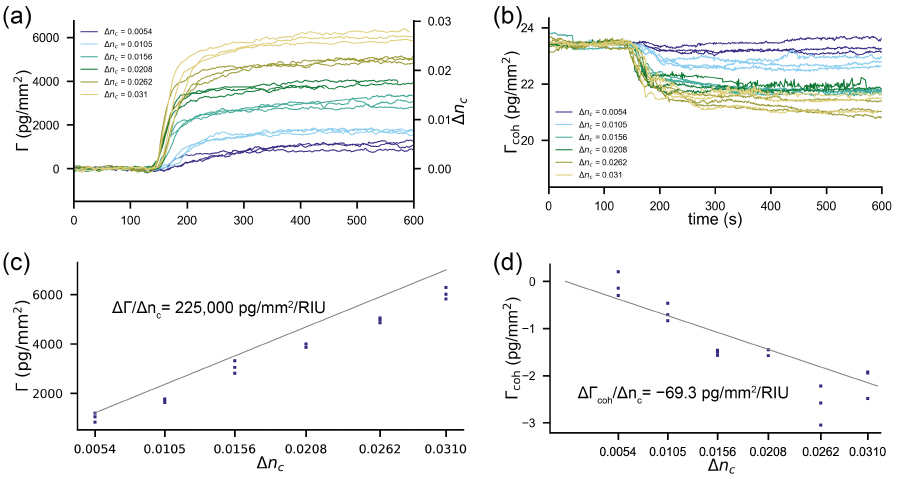
Figure 2. Cross-sensitivity to refractive index discontinuities of the two readout channels of the combined sensor: the curves are not step responses due to diffusive mixing within the suboptimal fluidics of the device. ( a ) Refractometric readout channel: The signal is displayed in both RIU (refractive index units) as well as pg/mm 2 (surface mass density Γ ). ( b ) Diffractometric readout channel. ( c ) The experimentally measured change in surface mass density Γ as a function of the applied refractive index change ∆ n c : the grey line is a theoretical prediction from Equation (4). ( d ) The experimentally measured change in coherent mass density Γ coh as a function of the applied refractive index change ∆ n c for the diffractometric sensor output: the grey line is a theoretical prediction from Equation